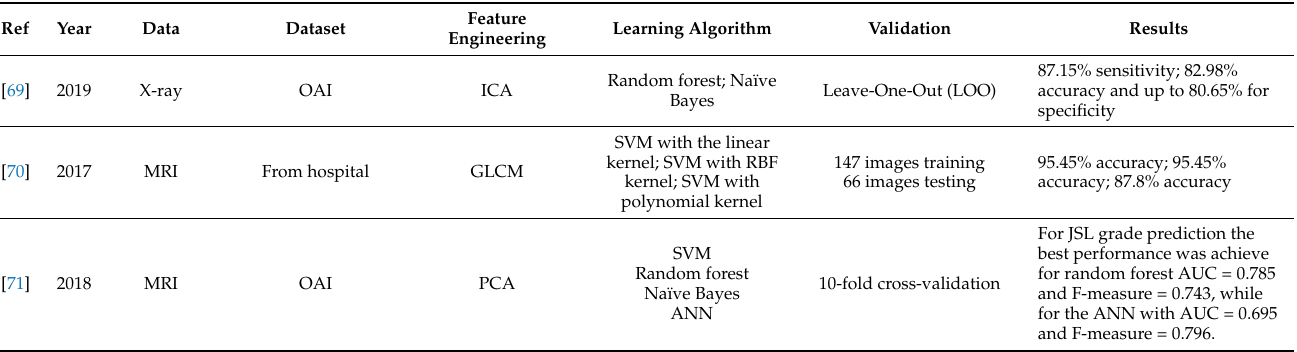
Table 2. Summary of deep learning and machine learning methods for studying knee bone segmenta- tion and